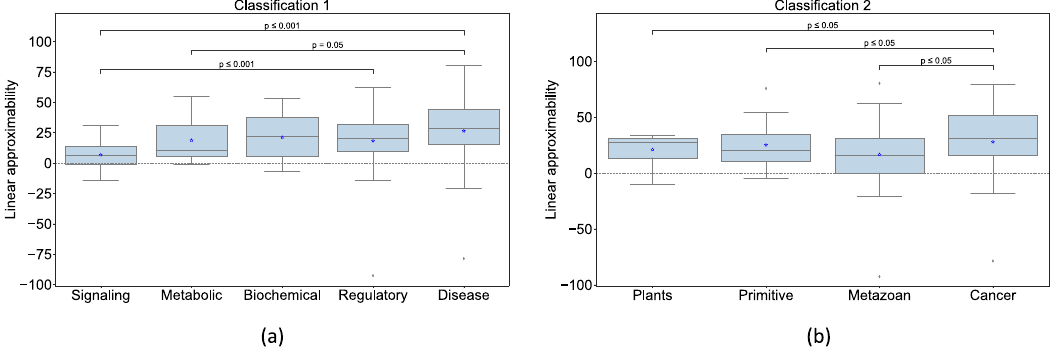
Fig. 3 The linear approximabilities of various categories of biological models. a Classi fi cation 1 (C1); b Classi fi cation 2 (C2). The categories in either classi fi cation are displayed in increasing order of variance. Each box represents the distribution of the linear approximabilities of the corresponding category. The p values indicate the statistical signi fi cance of the difference in the variance between pairs of categories; only the p values of signi fi cantly different pairs are shown. Statistical analysis by F -test of equality of